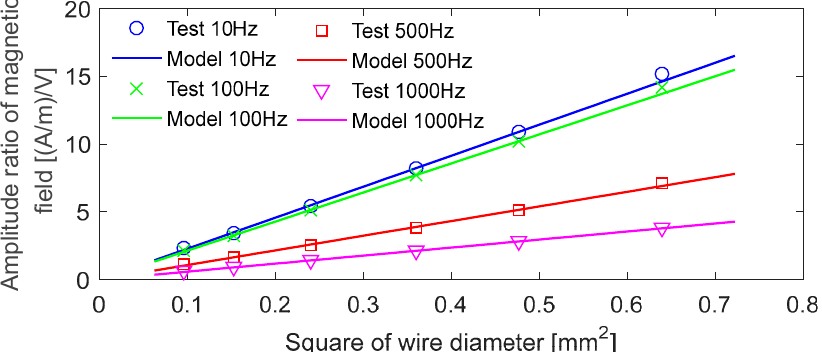
Figure 8. Linear curves of A H - D wire 2 from the model and test under different frequencies.